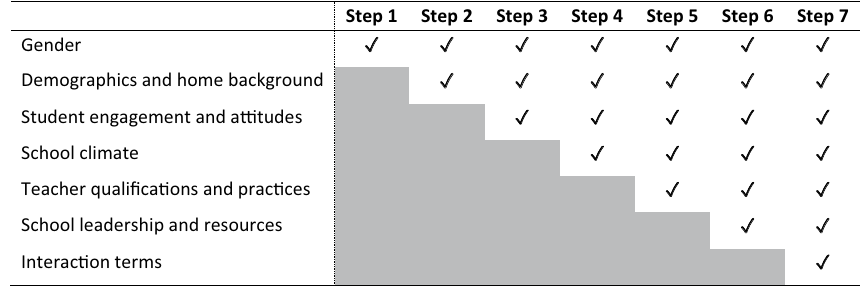
Table 1 Steps in building the hierarchical two‑level linear regression